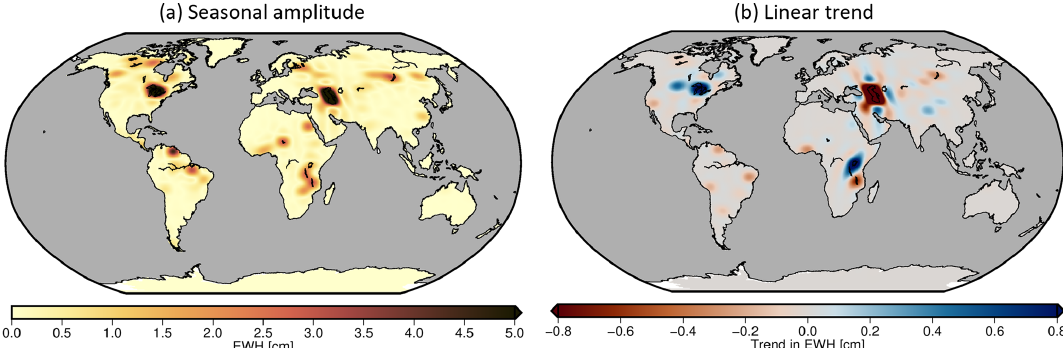
Figure 3. RECOG-LR on a global scale with its (a) mean seasonal amplitude and (b)